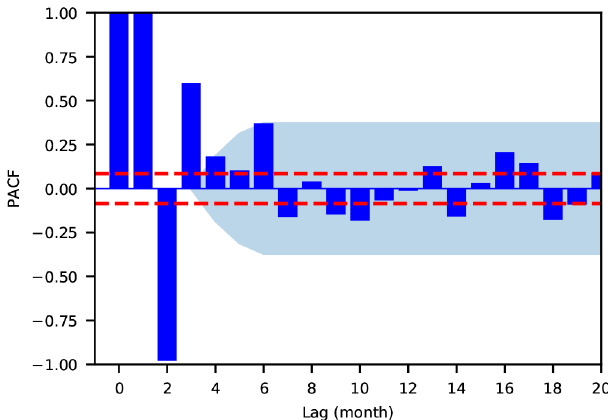
Figure 10. PACF of the first VMD signal component for the time- series data collected from the Huaxian station.